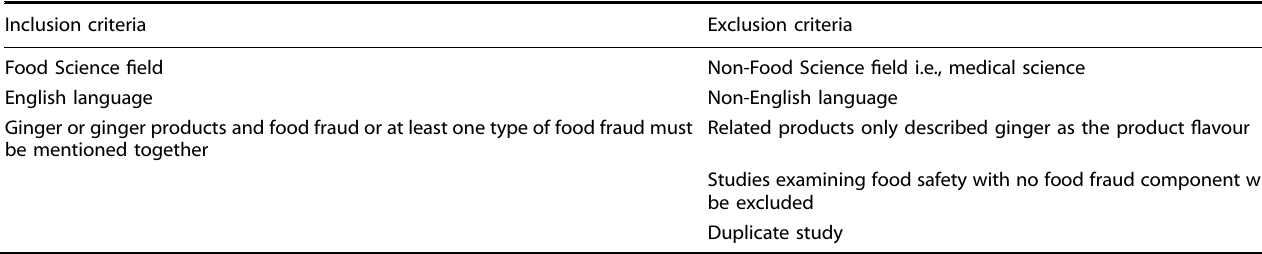
Table 1. Inclusion and exclusion criteria for the